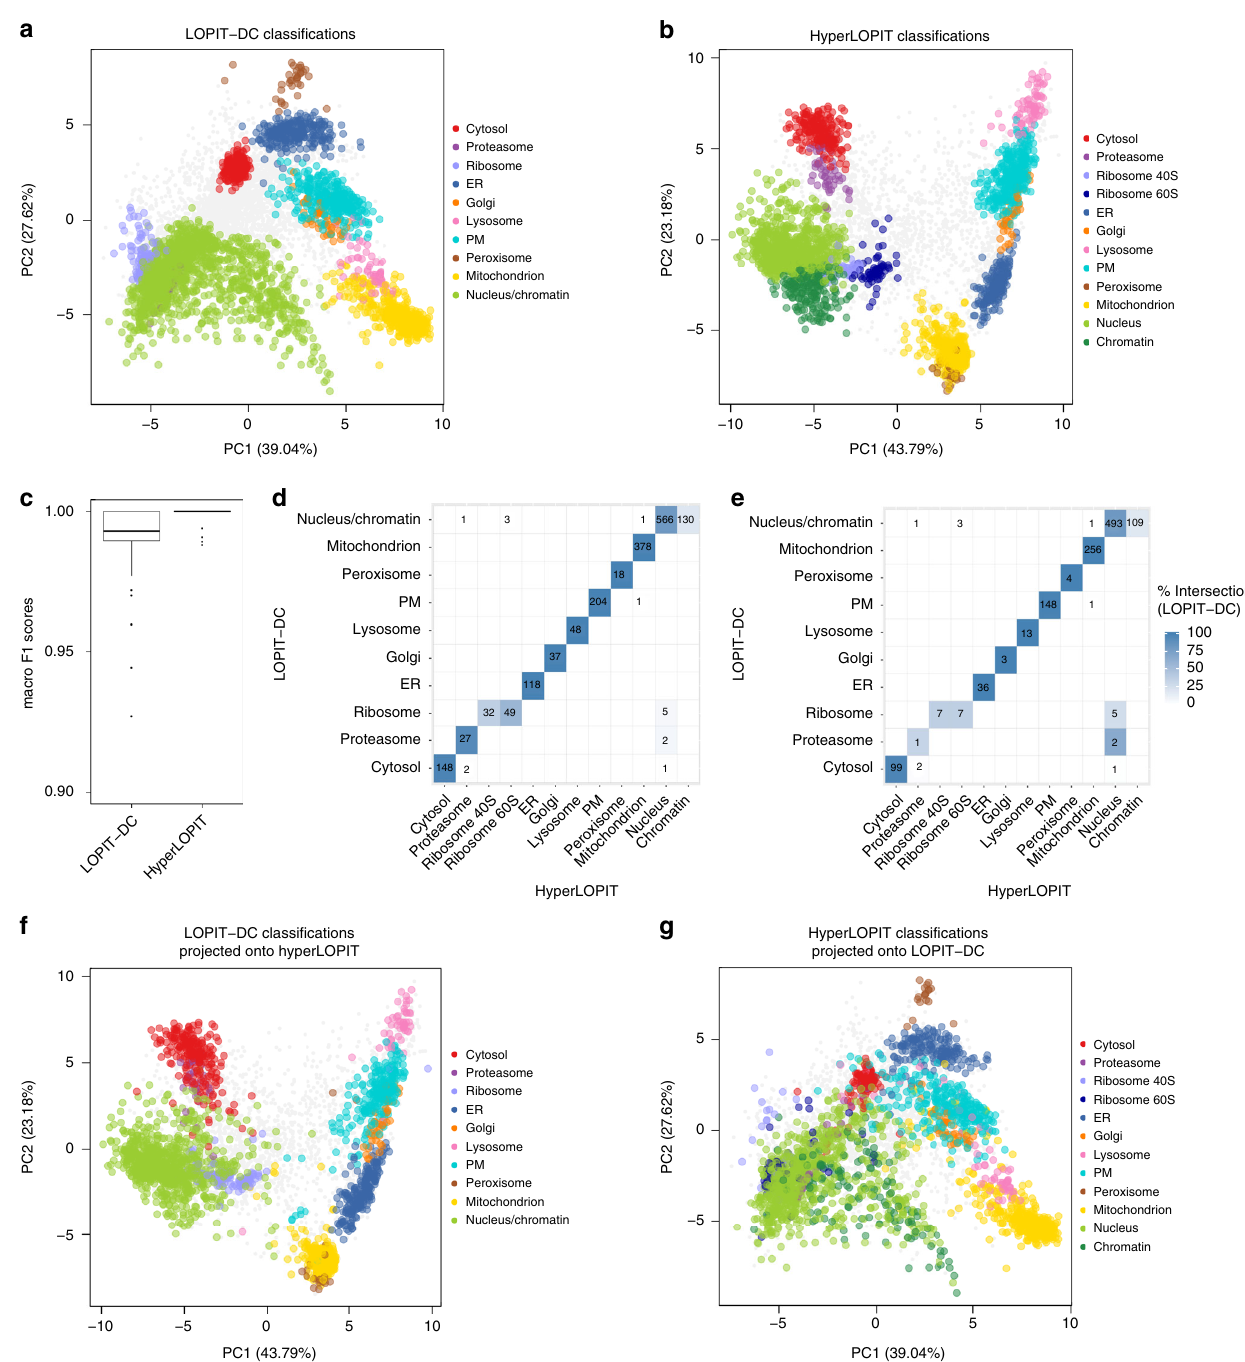
Fig. 4 LOPIT-DC protein localisation classi fi cations agree with hyperLOPIT. a , b PCA plots displaying SVM classi fi cation results after applying a 5% FDR cutoff for the LOPIT-DC ( a ) and hyperLOPIT ( b ) datasets. c Optimisation results (macro F1 scores) from SVM classi fi cation. For each boxplot, the line in the middle of the box is the median value, the vertical size of the box represents the interquartile range (IQR) and the whiskers represent the extremes of the data (de fi ned as those that do not exceed 1.5 × IQR from the middle of the data, and if no points exceed that distance, then the whiskers are simply the minimum and maximum values). d Overlap between the LOPIT-DC and hyperLOPIT protein subcellular localisation assignments (including markers), where the LOPIT-DC dataset is classi fi ed using 10 marker classes and the percentage intersection is calculated relative to the number of proteins classi fi ed by compartment in the LOPIT-DC data. e As per d but excluding markers. f , g LOPIT-DC classi fi cations projected onto the hyperLOPIT PCA ( f ) and vice versa ( g ). Proteins which were identi fi ed by both LOPIT-DC and hyperLOPIT are shown We fi nd 4162 proteins in common between the U-2 OS based protein localisation assignment including organelle markers LOPIT-DC and hyperLOPIT datasets (including the 579 sub- (1771 proteins) and Fig. 4e depicts an overview of the cellular markers). Figure 4d provides an overview of the classi fi cation excluding markers (1192 proteins). The majority classi fi cation of these proteins to the classes used for SVM- of the chromatin and nucleus as well as the ribosome 40S and